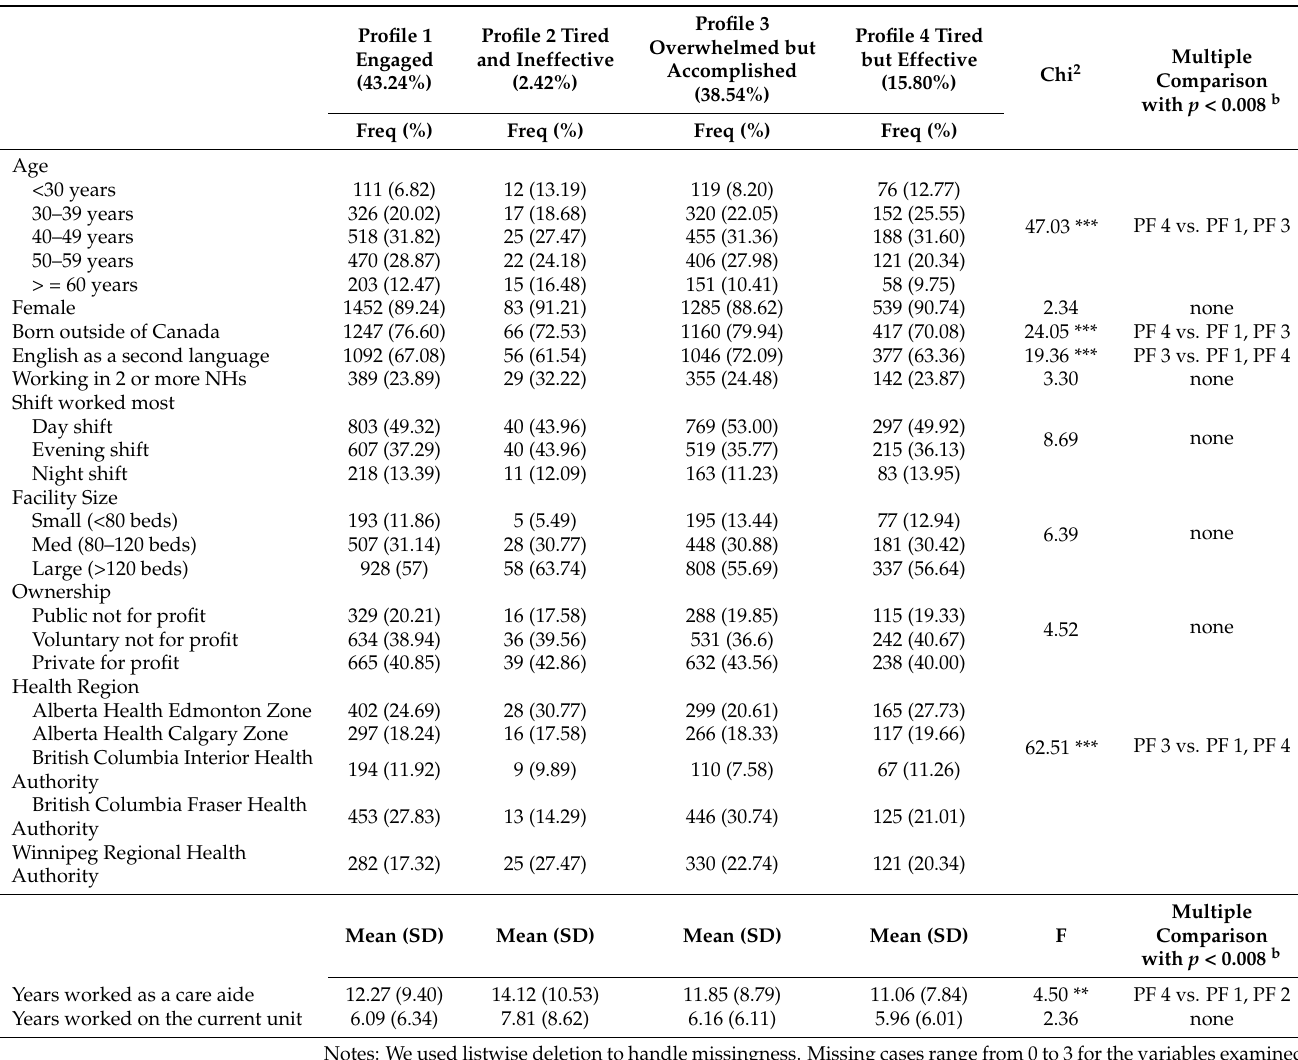
Table 3. Demographic characteristics by profile membership a ( n = 3765).